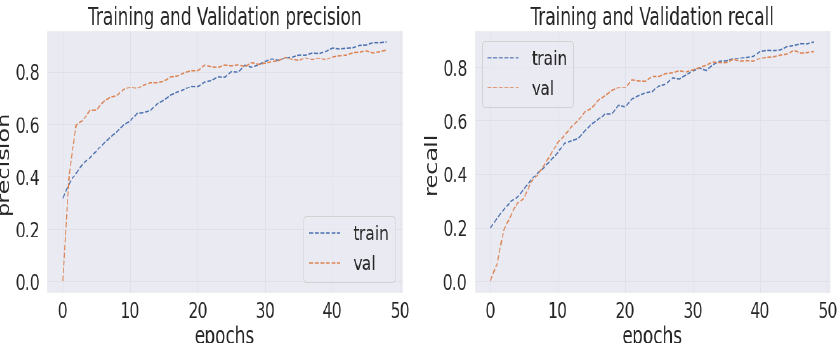
Figure 8. The left corner of the image represents the training and validation precision graph, and the right corner shows the training and validation recall